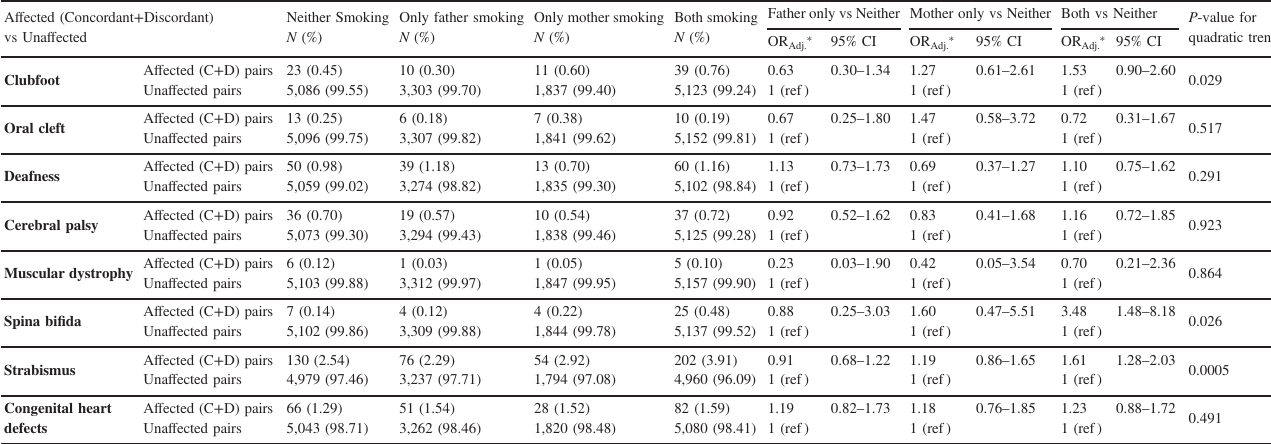
A ff ected (C+D) pairs 66